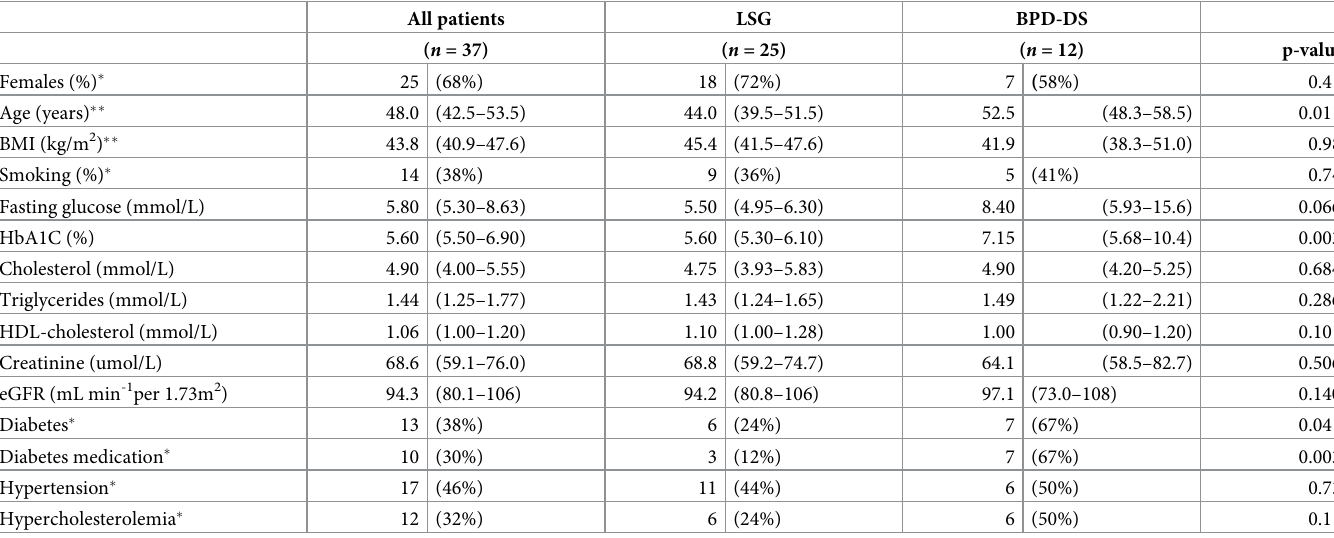
Table 1. Baseline characteristics of the study population according to bariatric surgical procedures. All patients